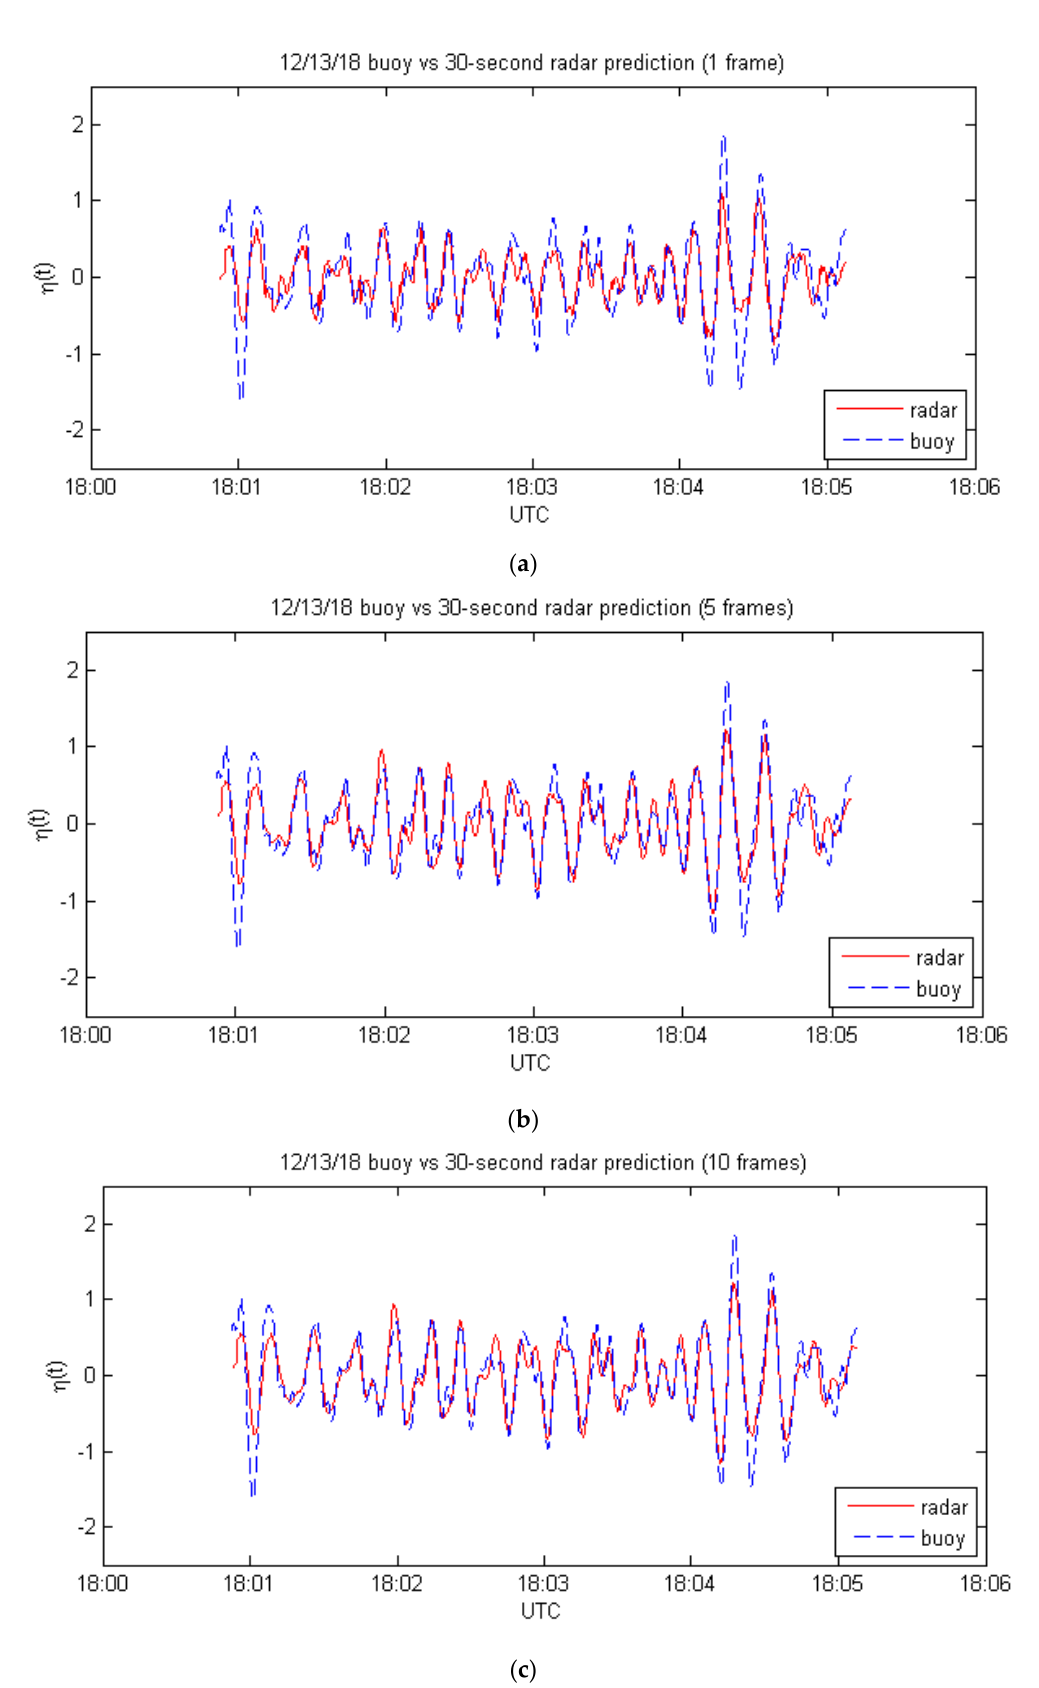
Figure 3. Comparison of buoy measurements with 30 s radar predictions for: ( a ) one frame, from Equation (1); ( b ) 5 frames, from Equation (12); ( c ) 10 frames, from Equation (12).